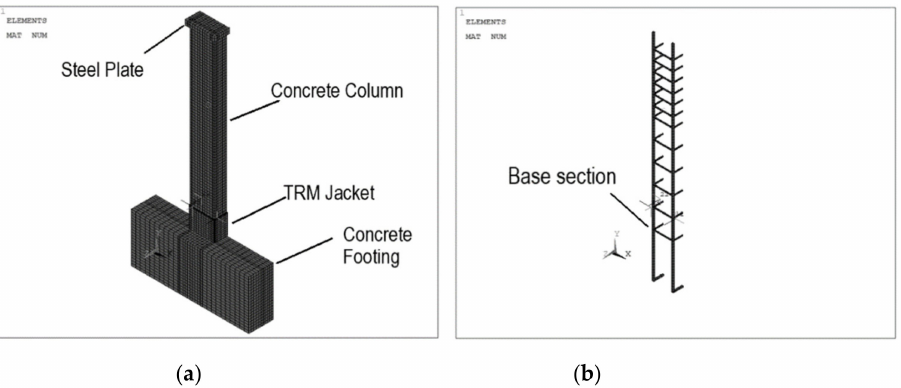
Figure 3. ( a ) Geometry of the strengthened models; ( b ) reinforcement details.